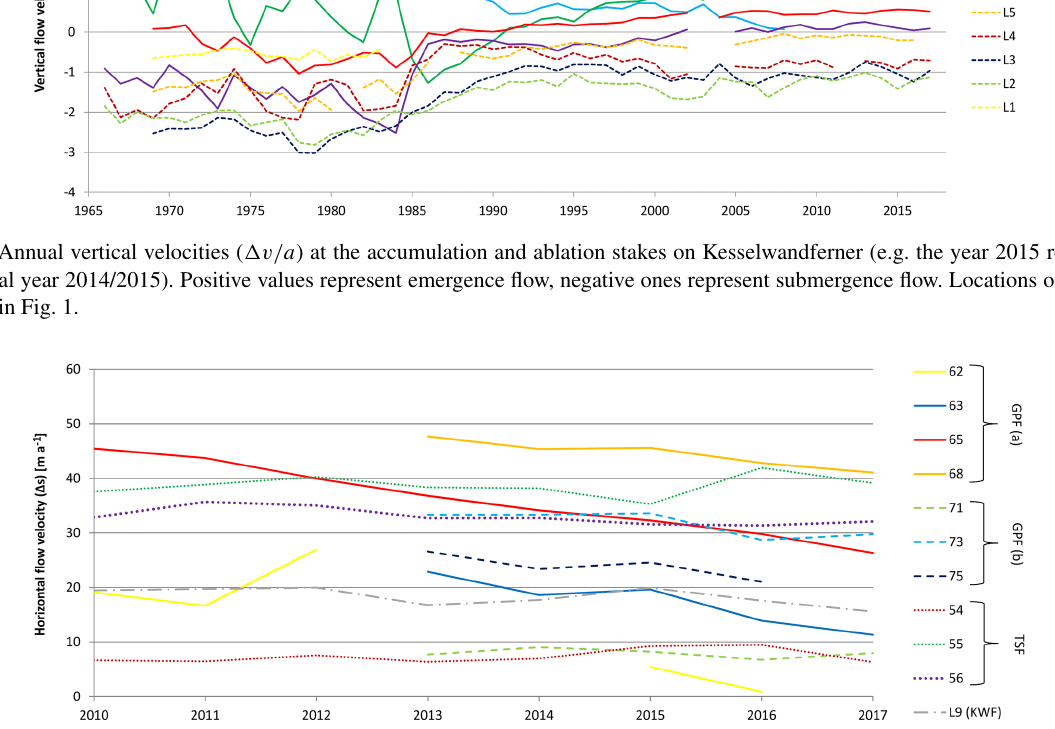
Figure 6. Annual horizontal flow velocities ( (cid:49)s/a ) on Gepatschferner and Taschachferner and L9 at Kesselwandferner for comparison (e.g. the year 2015 refers to the hydrological year 2014/2015). GPF (a) : selection of the longitudinal stakes at the tongue of Gepatschferner. GPF (b) : three stakes at the cross-profile. Locations of the stakes are shown in Fig. 1: Stake 71 – orogr. left side; Stake 73 – centre; Stake 75 – orogr. right